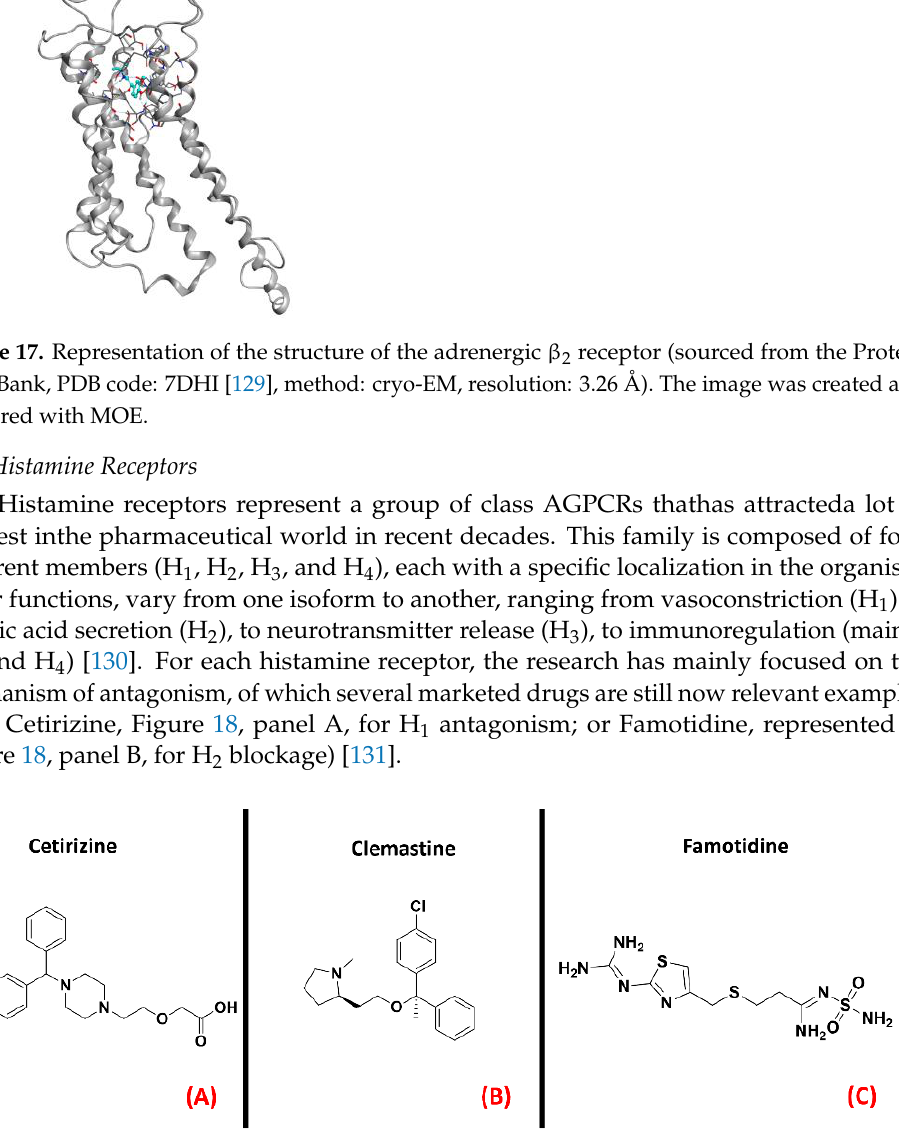
Figure 18. The chemical structures of the H 1 receptor antagonists Cetirizine ( A ) and Clemastine ( B ). The H 2 receptor antagonist Famotidine is also reported ( C ).